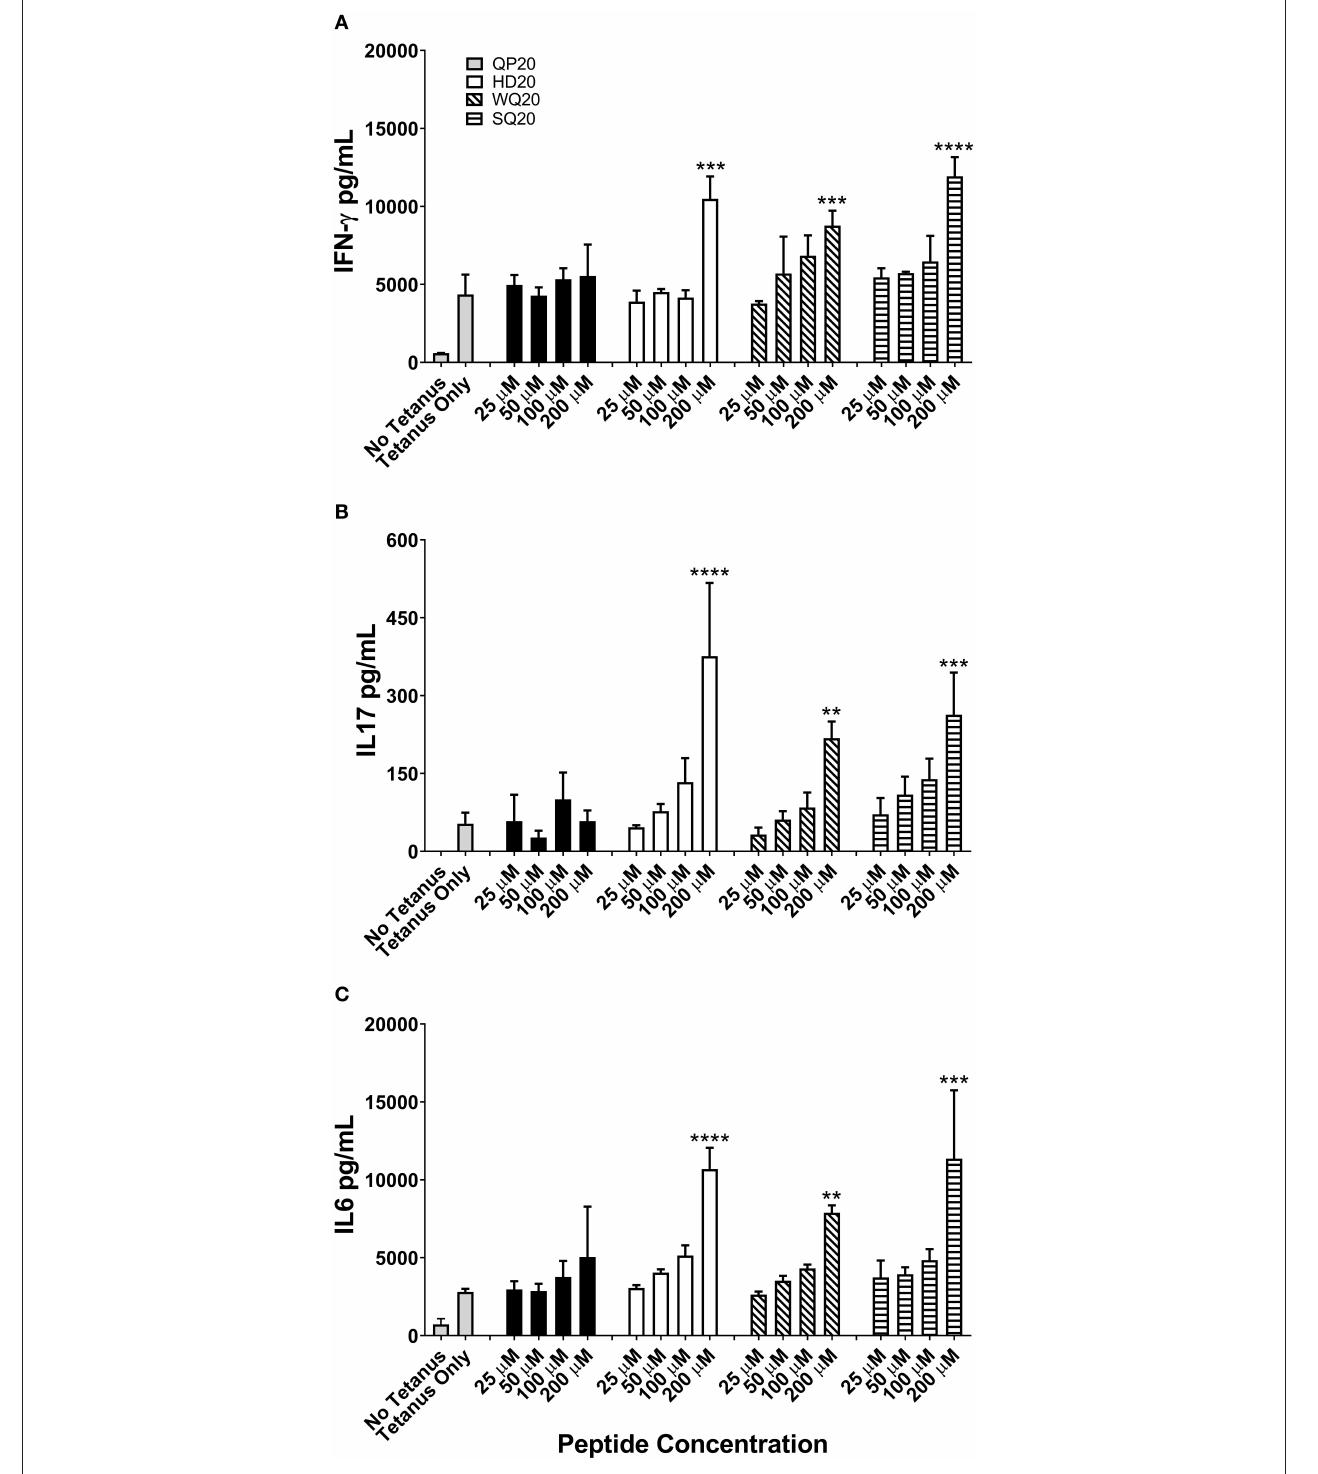
FIGURE 3 | PD1-binding peptides enhance cytokine secretion from tetanus toxoid stimulated human PBMCs. (A–C) PBMCs from a single donor were stimulated with tetanus antigen (5 µ g/mL). Individual PD1-binding peptides were added at concentrations ranging from 25 to 200 µ M. Cells were cultured for 4 days and supernatant IFN- γ (A) , IL-17 (B) , and IL-6 (C) levels were measured by ELISA. Data are expressed as the mean ± standard deviation (SD). Significant differences between tetanus only and PD1-binding peptide treated PBMCs were determined using a one-way ANOVA multiple comparisons test, and significance is denoted by ** p < 0.01, *** p < 0.001, and **** p < 0.0005.